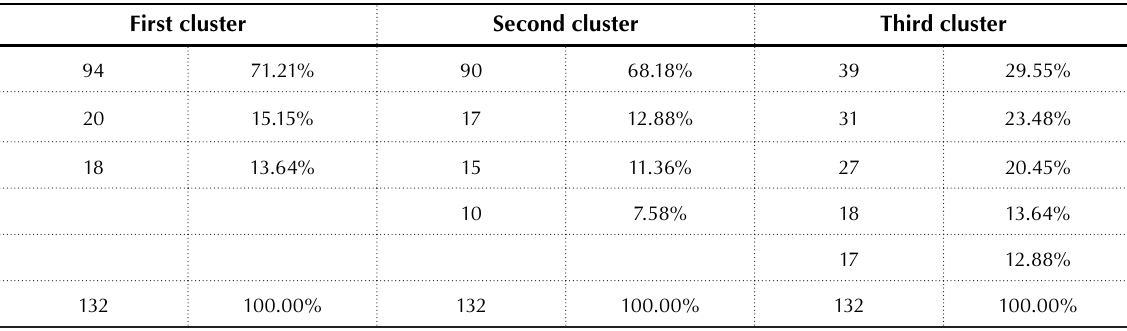
Table 2. Frequencies by cluster